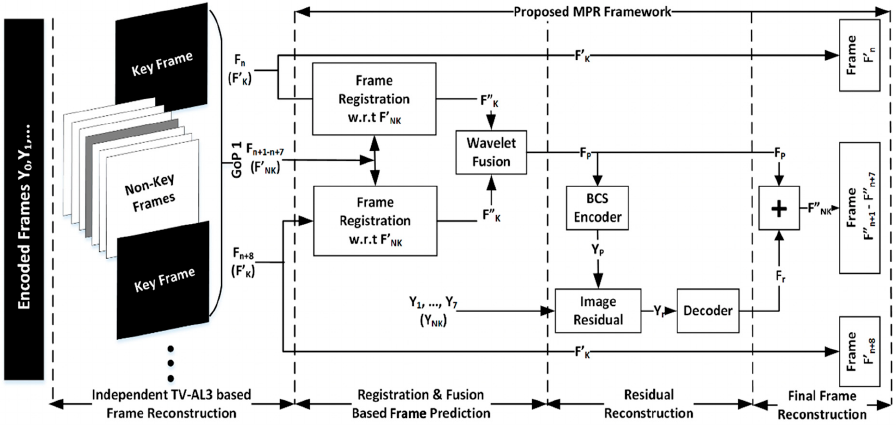
Figure 3. Reconstruction of frames using the proposed joint decoding (JD) framework.